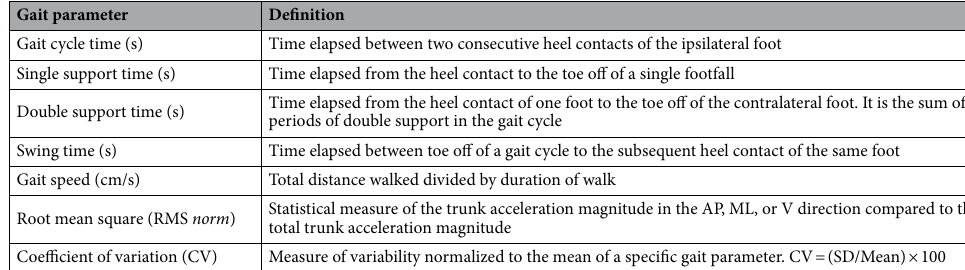
Table 4. Gait parameters and their